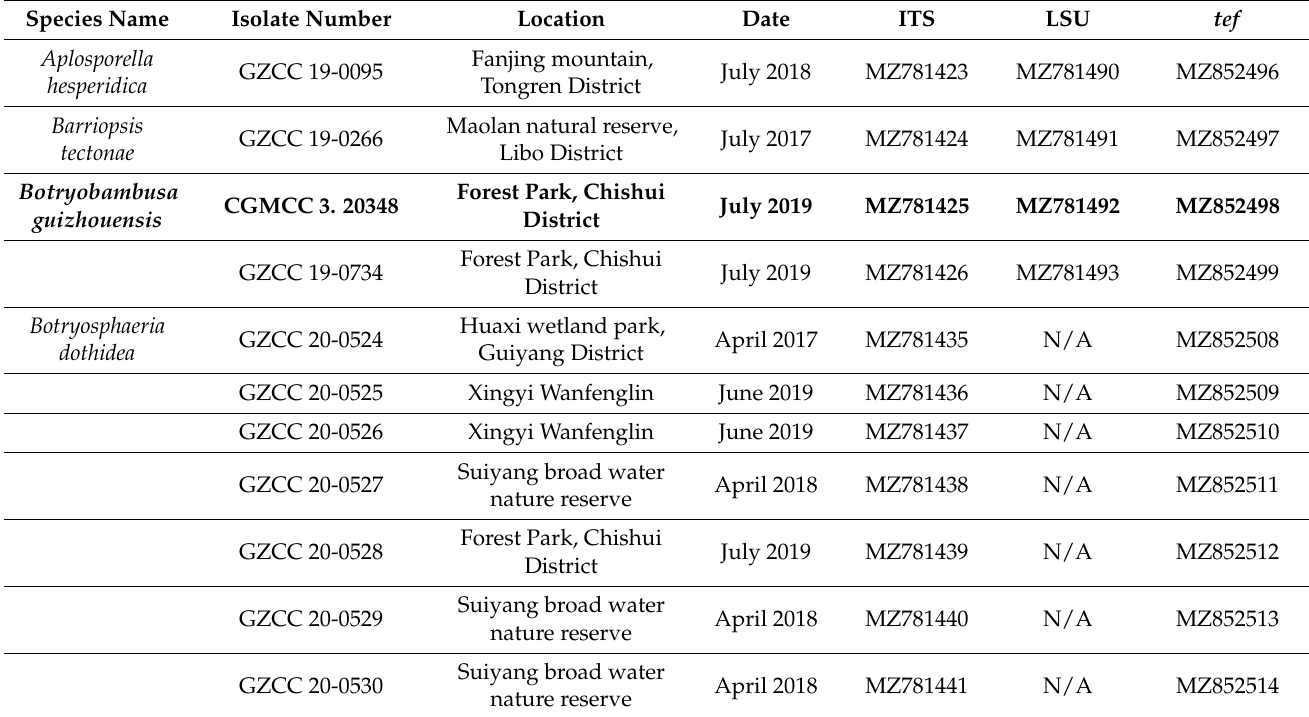
Table 1. Botryosphaeriales species isolated and characterized in this study. The details of the type species of novel taxa are given in bold. N/A: No sequence